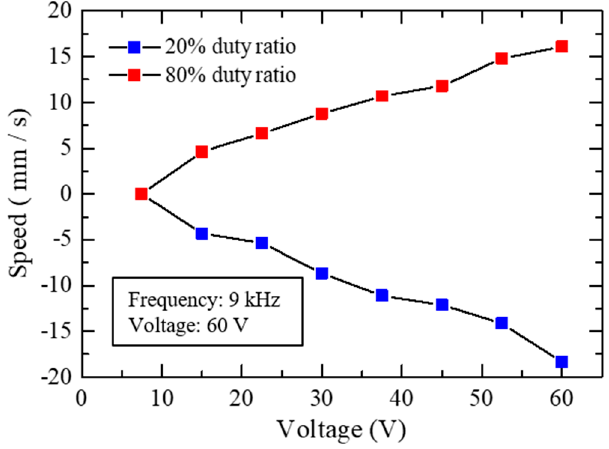
Figure 14. Driving characteristics of the slider 2 at different voltages.